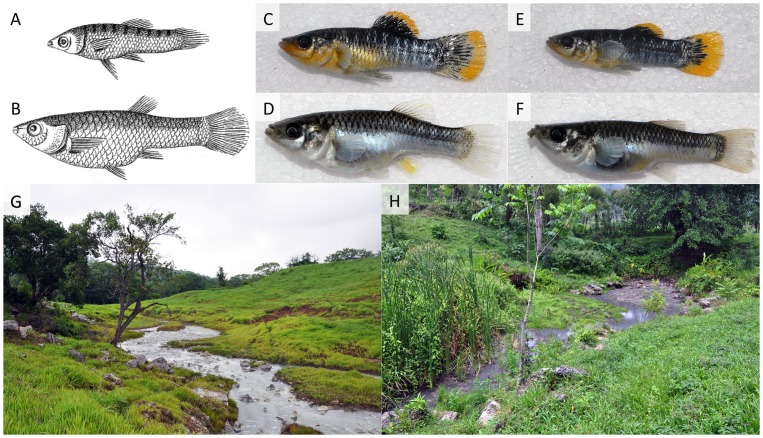

Poecilia thermalis and its natural habitat.A.-F. Representative specimens of Poecilia thermalis (males on top, females below). A. & B. represent artistic depictions of the species from the original description by Steindachner [35]. C.-F. are photos of freshly collected specimens of the P. thermalis from the large La Esperanza spring in 2012. G. The type locality of P. thermalis at La Esperanza (large spring), Chiapas, Mexico, a typical sulfidic spring habitat. H. A second, smaller sulfide spring (La Esperanza small spring) in close proximity to the type locality, which is also inhabited by P. thermalis.